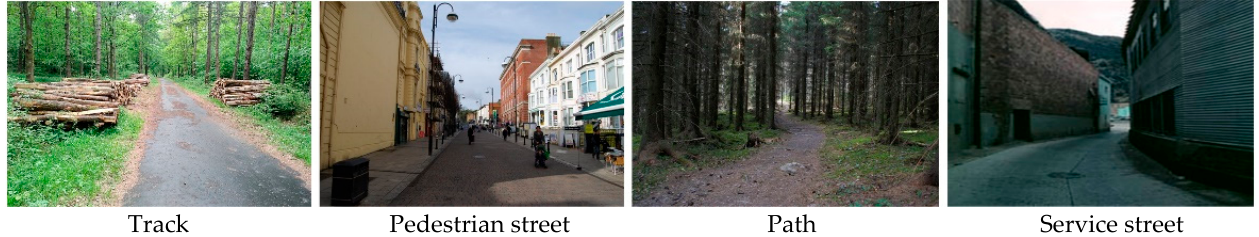
Figure 10. The four road types are negatively correlated with running. These images corresponding to these road types are from the OSM road classification document.